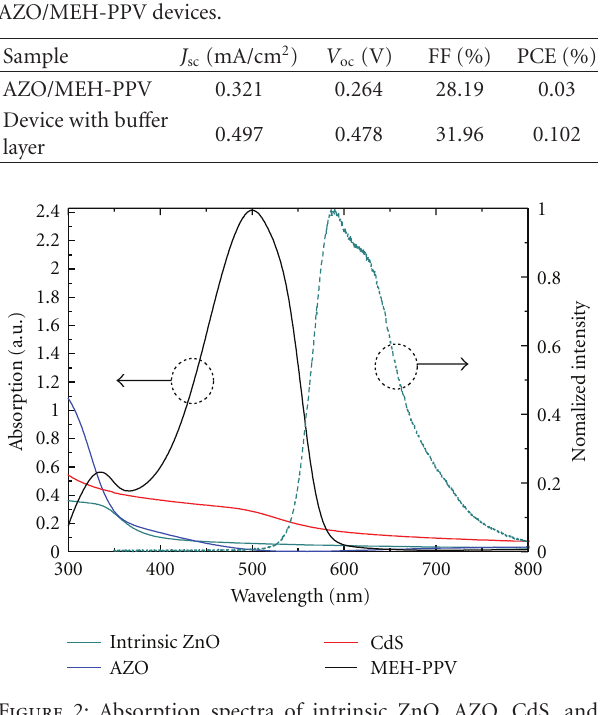
Figure 2: Absorption spectra of intrinsic ZnO, AZO, CdS, and MEH-PPV thin film (left). PL spectrum of MEH-PPV thin film (right).